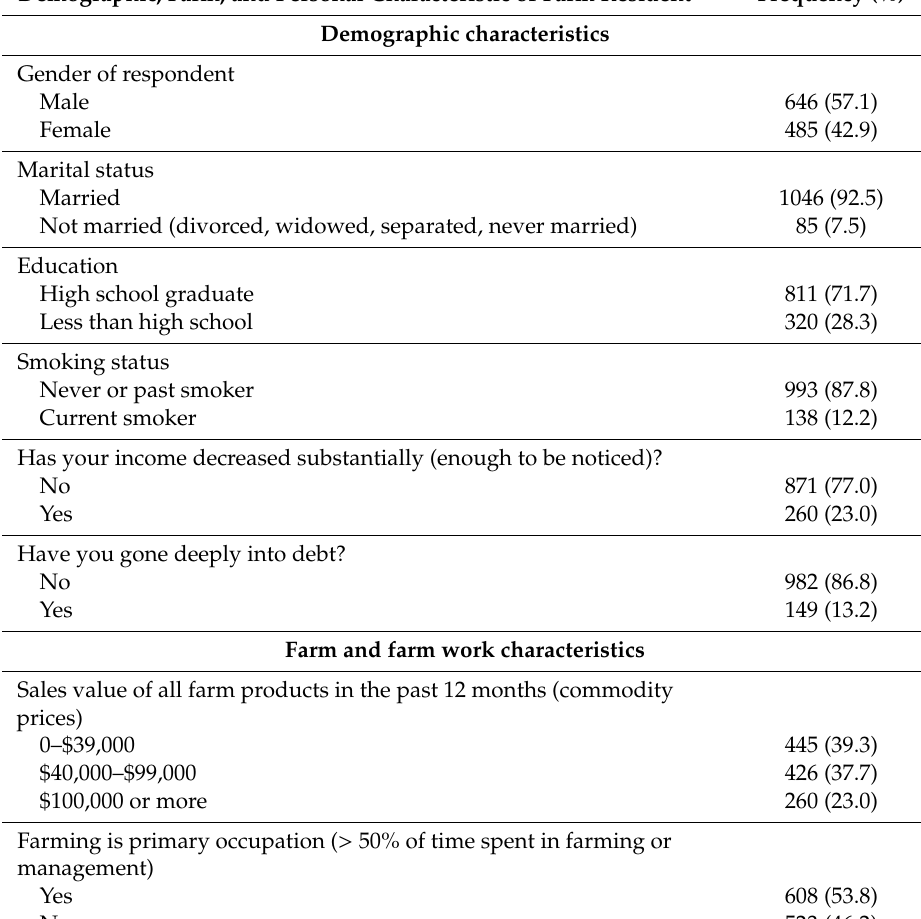
Table 1. Demographics and farm characteristics from a random sample of 1131 Colorado farm residents used in training a neural network